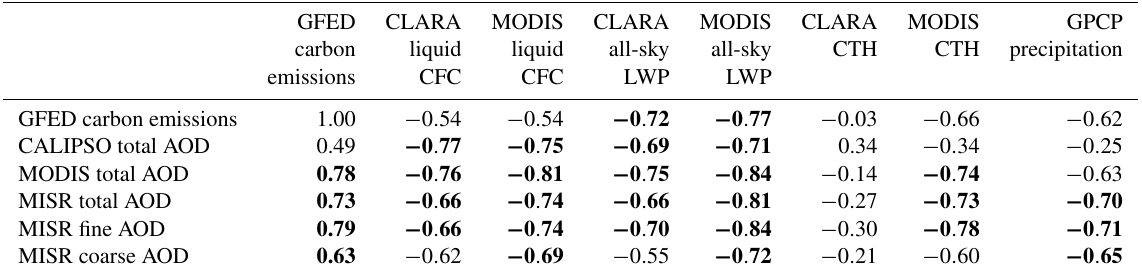
Table 2. Linear correlation coefficients of November–December mean GFED BC + OC emissions and AOD time series with cloud properties and precipitation time series over southern China from 2006 to 2015 (2007 to 2015 for CALIPSO AOD). Significant correlations are indicated with boldface. GFED CLARA MODIS CLARA MODIS CLARA MODIS GPCP carbon liquid liquid all-sky all-sky CTH CTH precipitation emissions CFC CFC LWP LWP GFED carbon emissions 1.00 − 0 . 54 − 0 . 54 − 0 . 72 − 0 . 77 − 0 . 03 − 0 . 66 − 0 . 62 CALIPSO total AOD 0.49 − 0 . 77 − 0 . 75 − 0 . 69 − 0 . 71 0.34 − 0 . 34 − 0 . 25 MODIS total AOD 0.78 − 0 . 76 − 0 . 81 − 0 . 75 − 0 . 84 − 0 . 14 − 0 . 74 − 0 . 63 MISR total AOD 0.73 − 0 . 66 − 0 . 74 − 0 . 66 − 0 . 81 − 0 . 27 − 0 . 73 − 0 . 70 MISR fine AOD 0.79 − 0 . 66 − 0 . 74 − 0 . 70 − 0 . 84 − 0 . 30 − 0 . 78 − 0 . 71 MISR coarse AOD 0.63 − 0 . 62 − 0 . 69 − 0 . 55 − 0 . 72 − 0 . 21 − 0 . 60 − 0 .